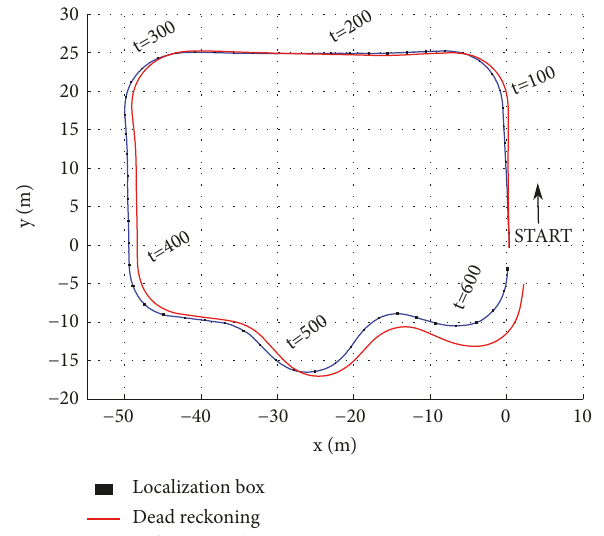
Figure 15: Localization trajectory of Sequence 1.